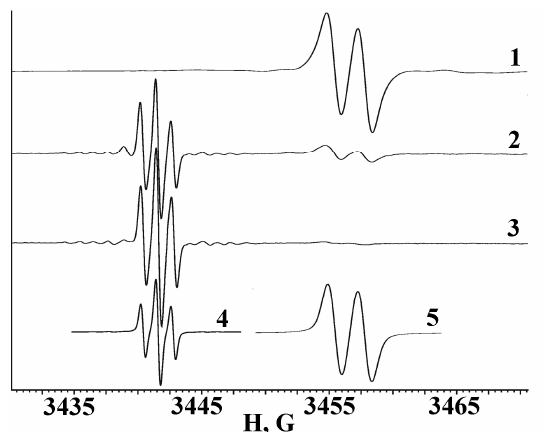
Figure 9. The X-band EPR spectrum of the mixture “ L 2 + PbO 2 ” in toluene immediately after mixing the reagents (spectrum 1), after stirring for 10 min (spectrum 2), and after stirring for 20 min (spectrum 3); Simulated EPR spectra (WinEPR SimFonia 1.25): triplet with parameters g i = 2.0050, a i (2 1 H) = 1.1 G (spectrum 4), doublet with parameters g i = 1.9967, a i ( 1 H) = 2.3 G (spectrum 5).